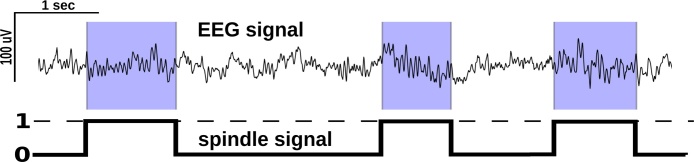
Definition of spindle signal. In segments where spindles were detected by a procedure described in Atherton et al. (2016) and O’Reilly and Nielsen (2014) signal level was set to one while non-spindling segments to zero.